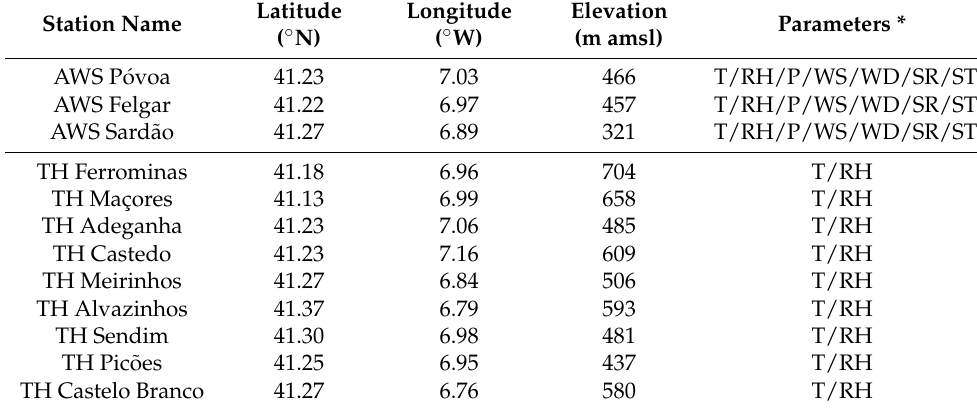
Table 1. Network stations (EPSG: 4230), along with their geographical coordinates (latitude and longitude), elevation, and recorded meteorological